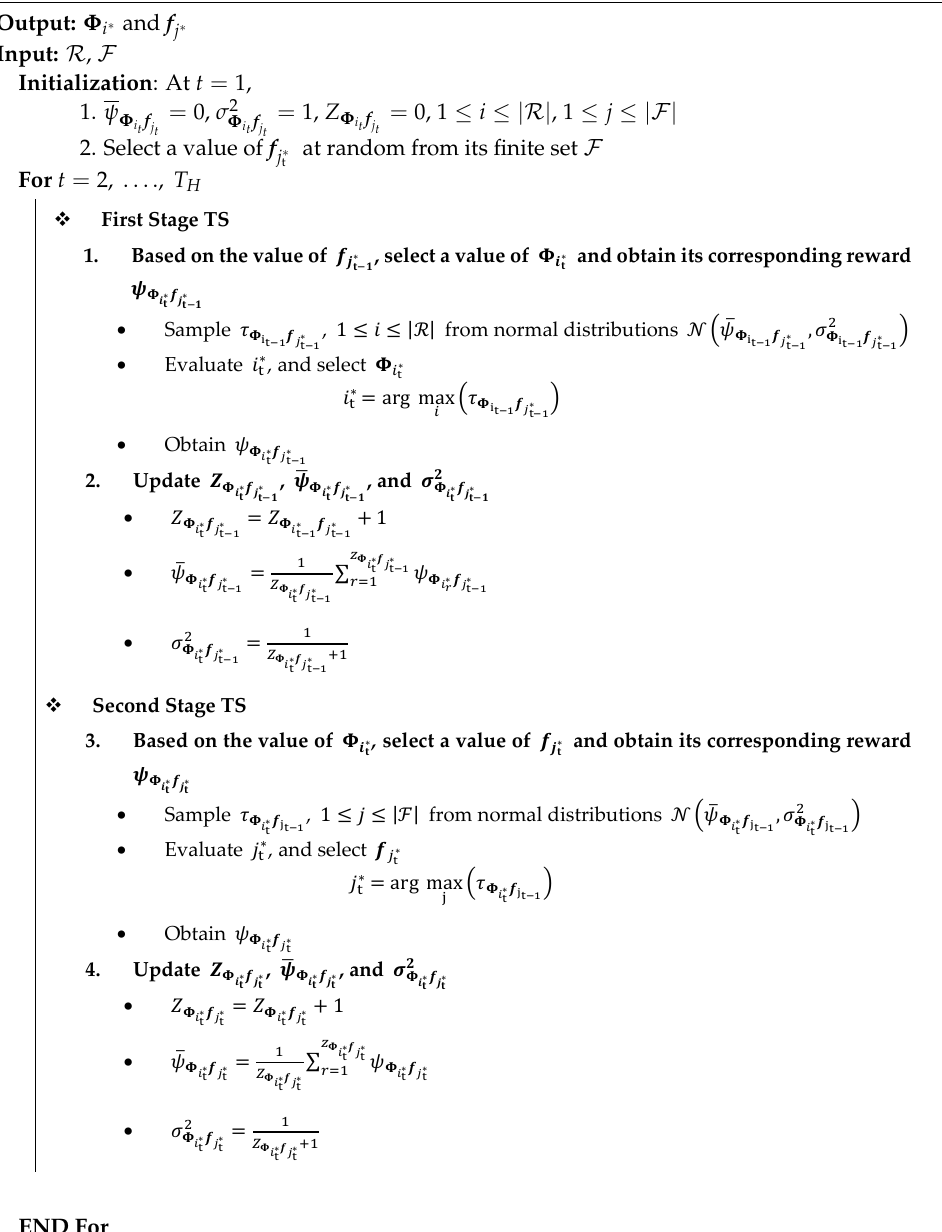
Algorithm 1. Nested Two-Stage TS Algorithm